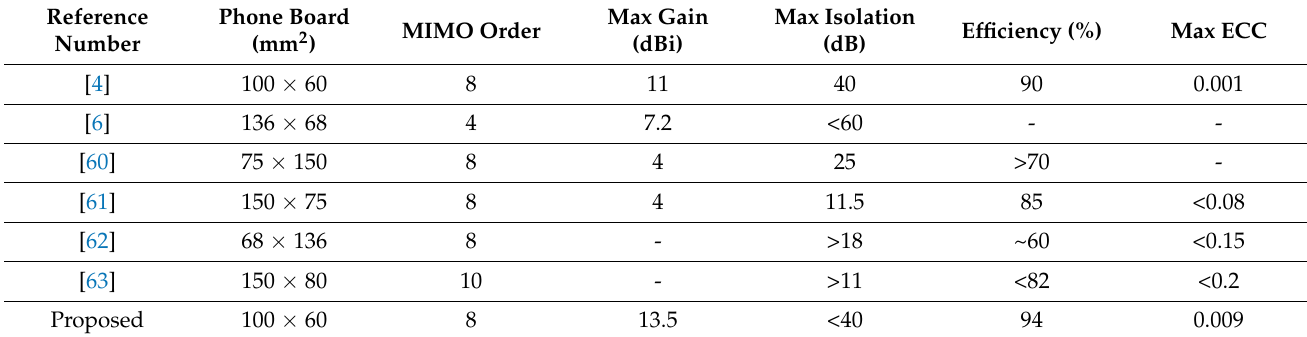
Table 7. Comparison of the performance of a few MIMO antennas for 5G